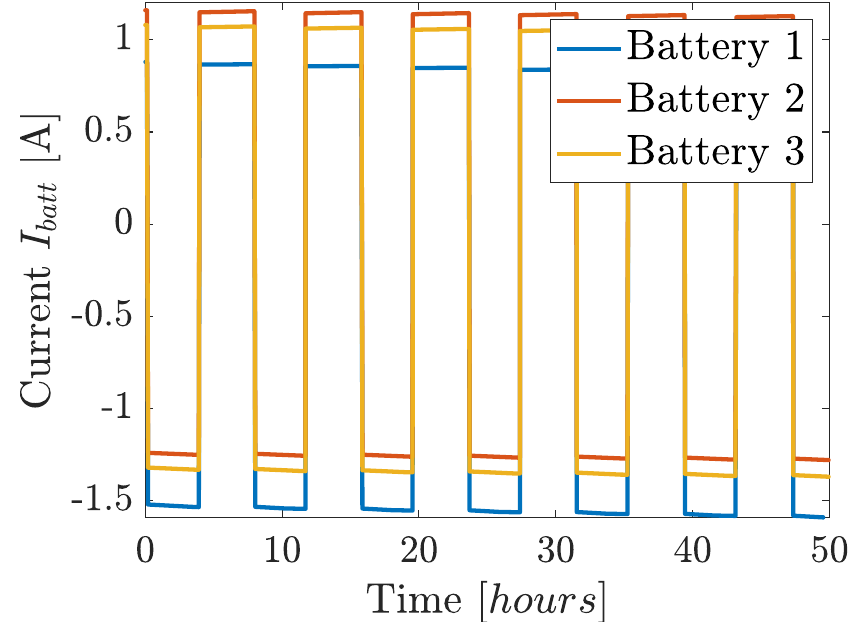
Figure 22. Current values for the advanced SoC